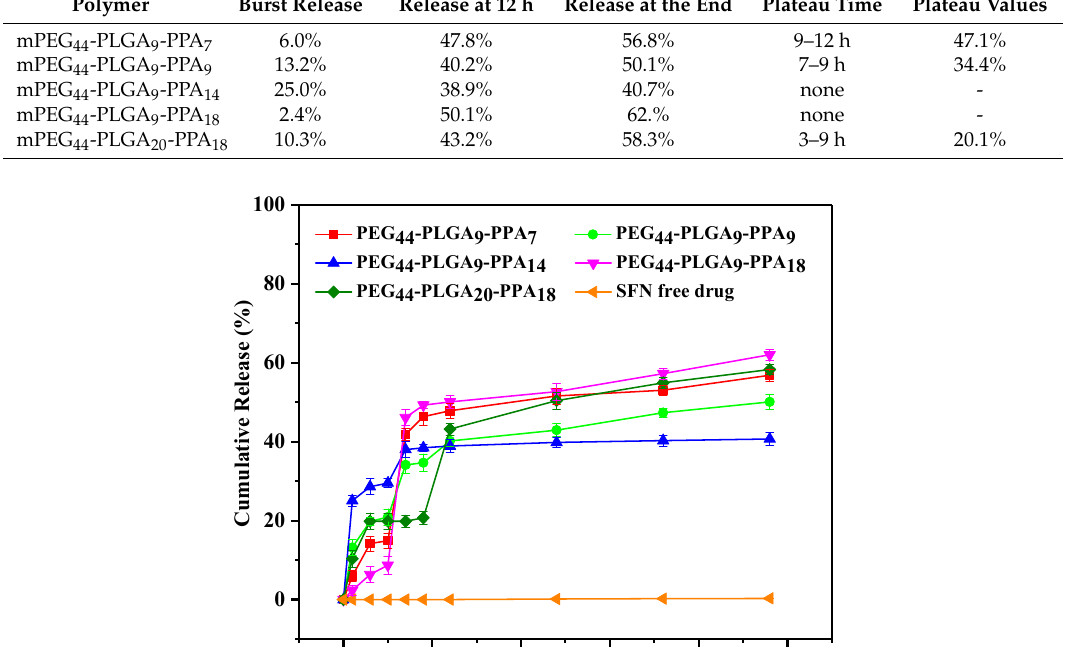
Figure 7. In vitro drug release profiles of SFN loaded mPEG-PLGA-PPA micelles at pH 7.4.